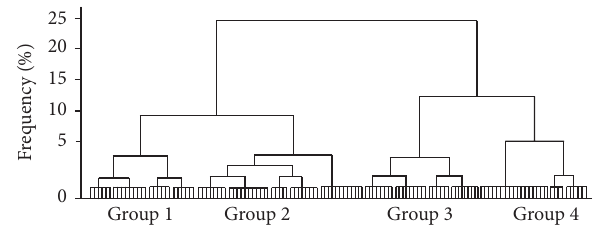
Figure 4: Breathing patterns and parasitemia could be used to group mice into two main clusters. Ward’s linkage cluster analysis illustrates the distance between the physiological cluster patterns in DBA/2 mice infected with P. berghei ANKA that developed ALI/ARDS and HP. Values were measured on the 7th DAI. The data are from 13 independent experiments; 𝑛 = 142 mice. Group 1 = 88.46% of individuals with ALI/ARDS and 11.53% with HP; group 2 = 57.77% of individuals with ALI/ARDS and 42.22% with HP; group 3 = 19.35% individuals with ALI/ARDS and 80.64% with HP; group 4 = 21.42% of individuals with ALI/ARDS and 78.57% with HP. ALI/ARDS: acute lung injury/acute respiratory distress syndrome; HP: hyperparasitemia.